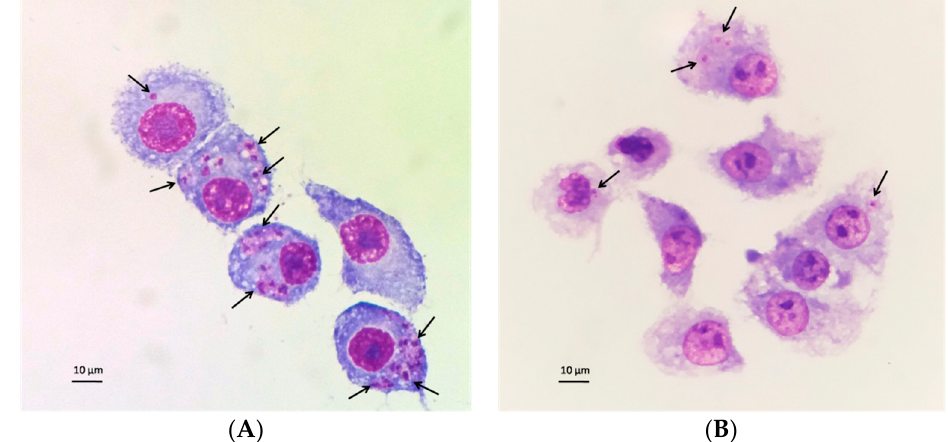
Figure 10. Effect of the MA gel on the infection of J774A.1 macrophages with L. infantum . ( A ) Infected and untreated control cultures. ( B ) Cultures treated with 15.63 µg/mL of Sb V of the MA gel. Amastigotes are indicated by arrows.